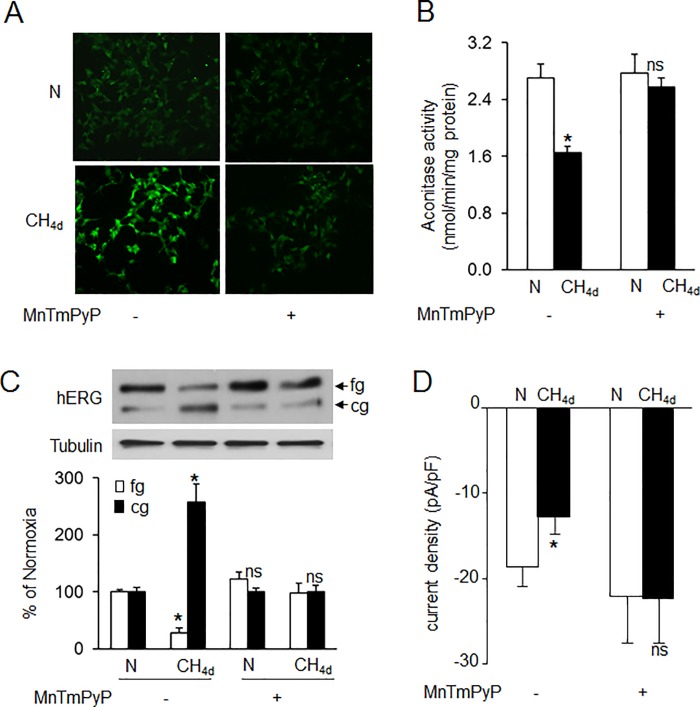
Role of reactive oxygen species (ROS) in continuous hypoxia (CH)-induced hERG trafficking defect.Analysis of ROS generation in SH-SY5Ycells exposed to normoxia (N) or CH4d with and without MnTmPyP (50μM), a membrane permeable ROS scavenger as measured by A) CM-H2DCFDA flourescence and B) cytosolic and mitochondrial aconitase activity. Data shown are mean ± SEM from 3 independent experiments. C) Representative immunoblot (top panel) and densitometric analysis (bottom panel; mean ± SEM; n = 3 individual experiments) of hERG protein with and without MnTmPyP treatment and D) HERG current densities measured in cells exposed to normoxia (N) or CH4d with and without MnTmPyP treatment. *denotes p <0.01. ns = not significant from control (N); p> 0.05.